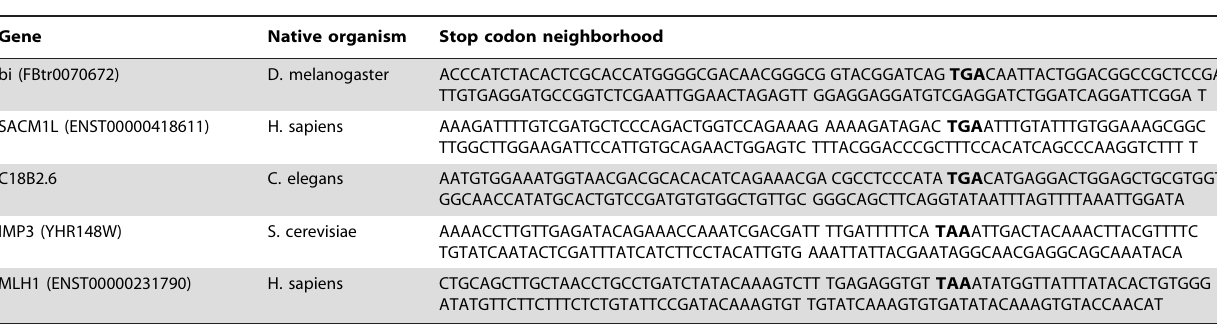
Table 2. Stop codon neighborhood